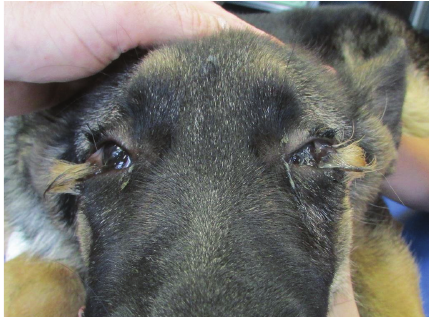
Figure 1: Case 1 appearance at initial presentation. Abnormal haired tissue and copious mucoid ocular discharge in OU.